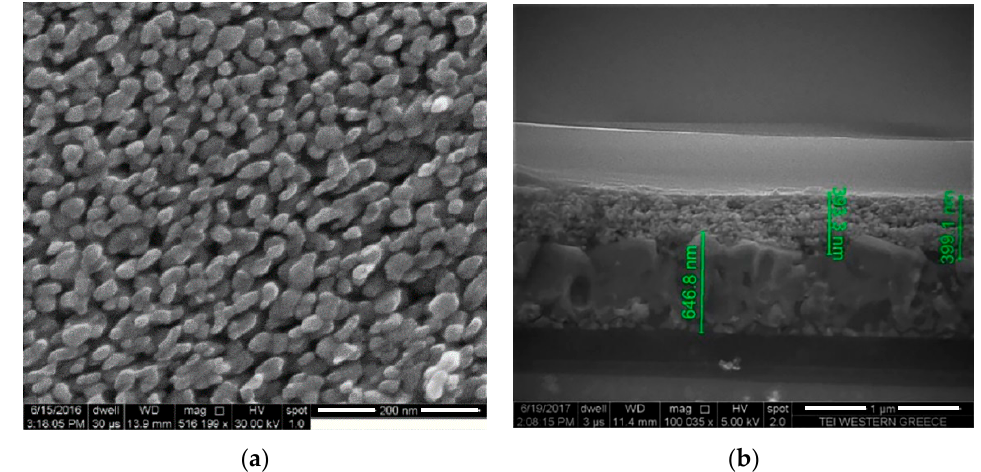
Figure 2. ( a ) Top view field-emission electron microscopy (FESEM) image and ( b ) cross section image of WO 3 films.